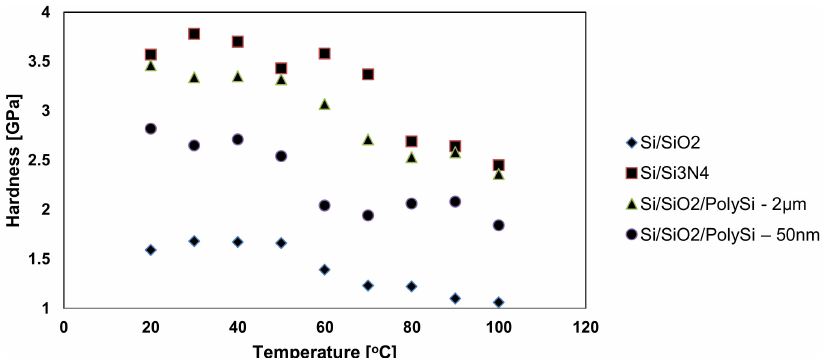
Figure 21. The hardness with respect to temperature for Si/SiO 2 , Si/Si 3 N 4 , Si/SiO 2 /PolySi—2 µ m and Si/SiO 2 /PolySi—50